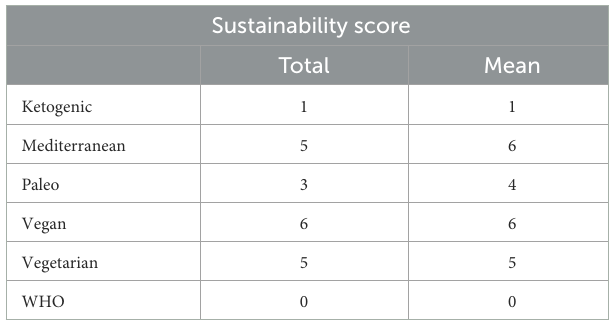
TABLE 3 Relative sustainability scores of each